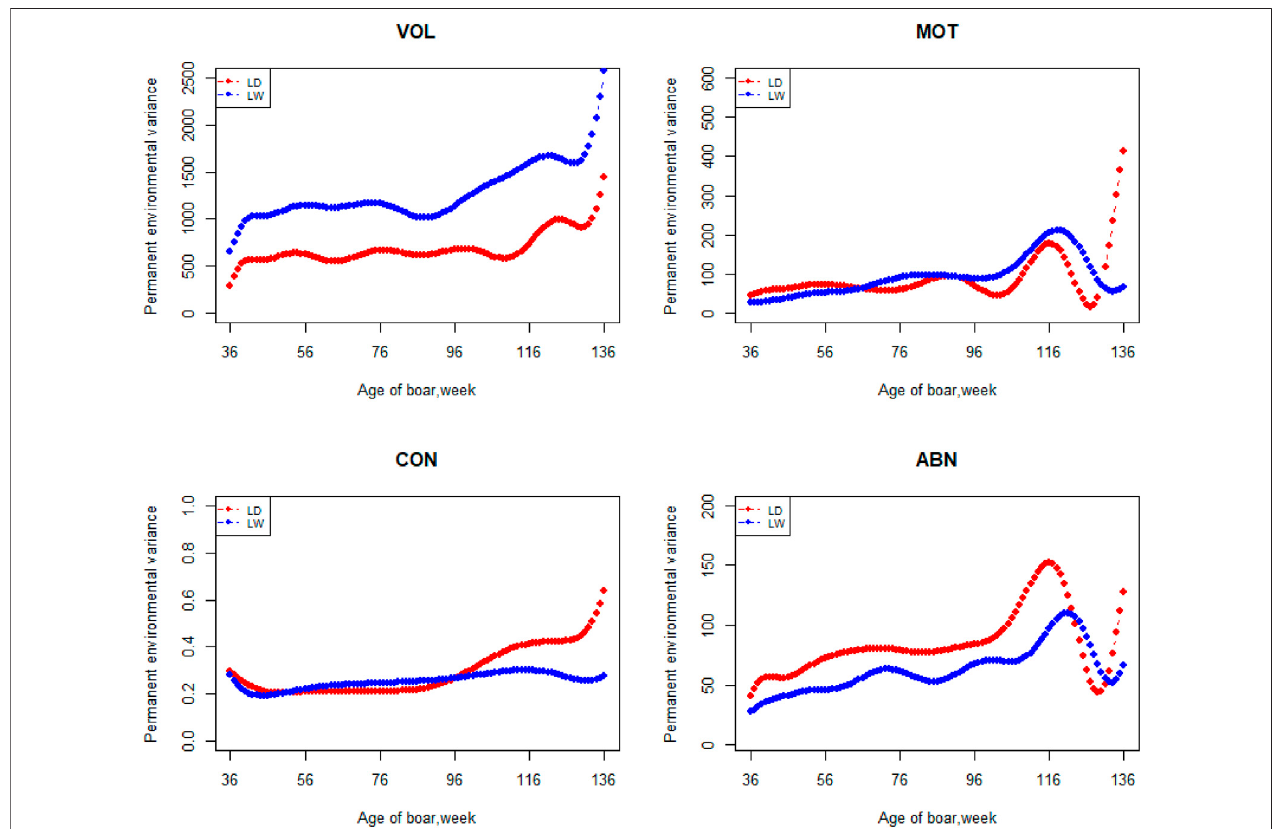
FIGURE 3 | Permanent environmental variance from 36 weeks to the age of 136 weeks, estimated with a random regression animal model.